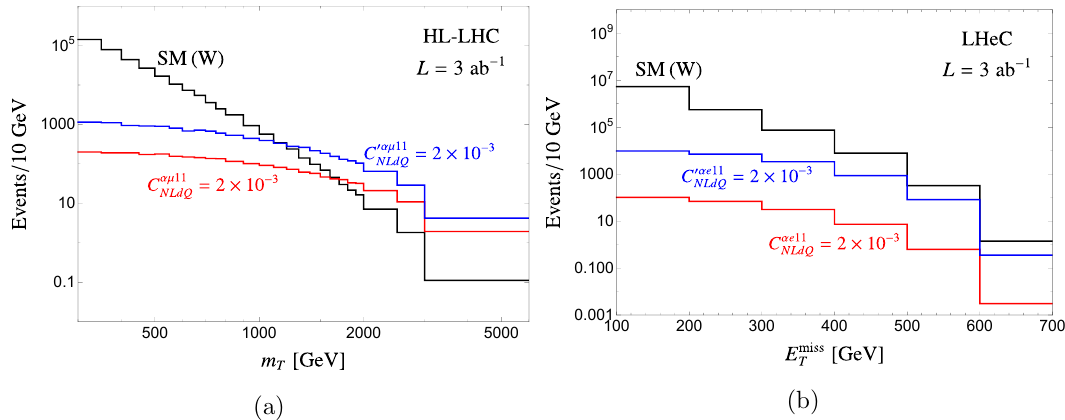
Figure 5. Left: distribution of m T at the HL-LHC with an integrated luminosity of 3 ab (cid:0) 1 . Right: distribution of E miss at the LHeC with 3 ab (cid:0) 1 and a 1.3 TeV center-of-mass energy. The T black histograms corresponds to the SM. The red (blue) histograms correspond to scalar (tensor) interactions with C NLdQ ( C 0 ) = 2 (cid:2) 10 (cid:0) 3 . NLdQ Coupling